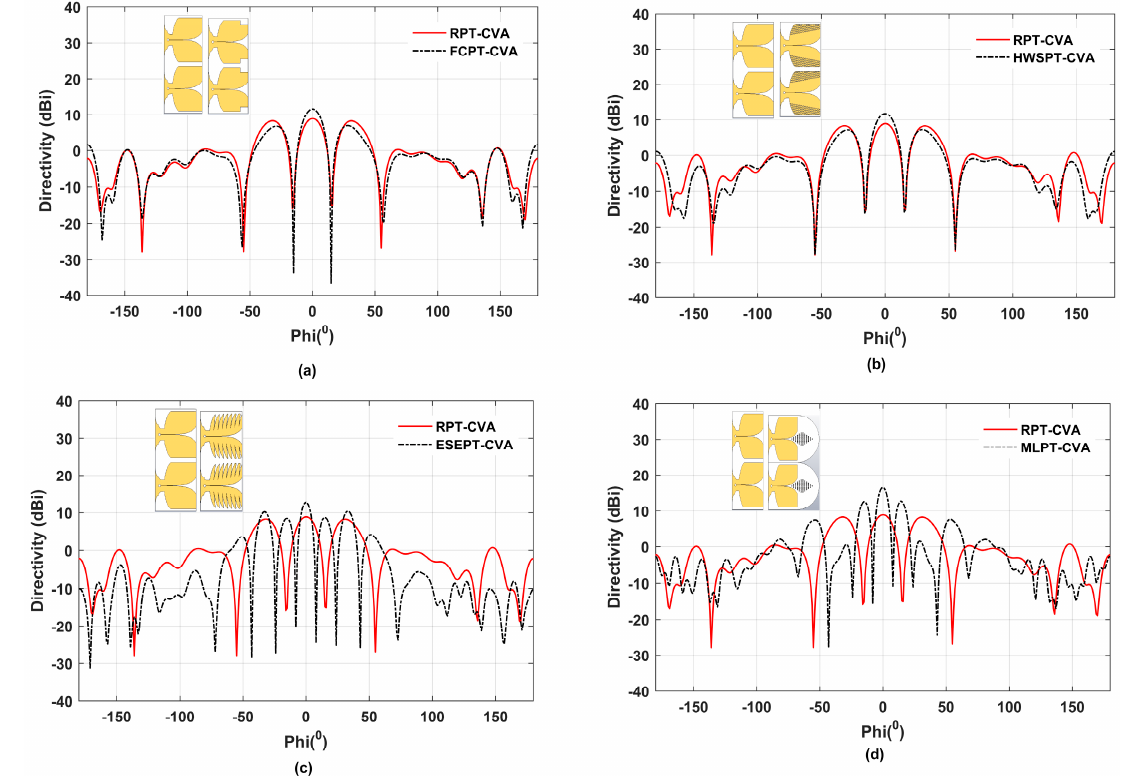
Figure 11. Radiation Pattern in the E-Plane of ( a ). RPT-CVA vs FCPT-CVA at 2 GHz, ( b ). RPT-CVA vs HFSPT-CVA at 2 GHz, ( c ) RPT-CVA vs ESE-CVA at 4 GHz, and ( d ). RPT-CVA vs MLPT-CVA at 4